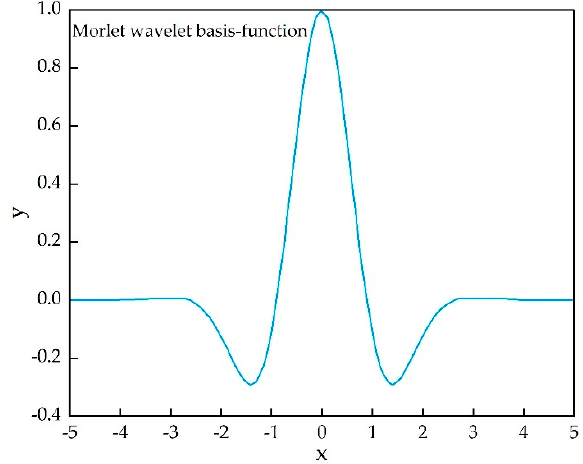
Figure 12. Morlet wavelet basis function curve.